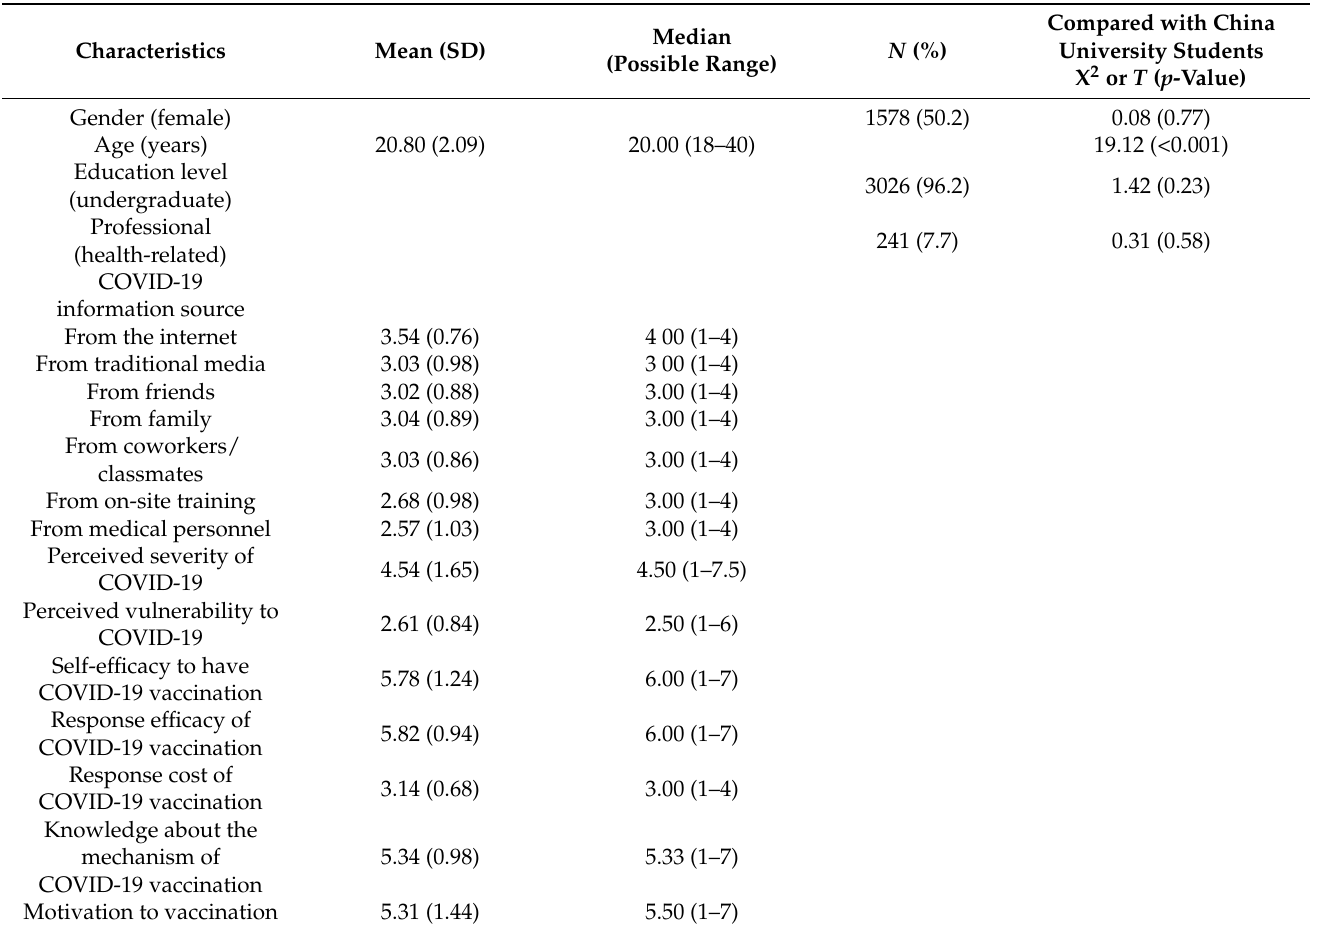
Table 2. Characteristics of the participants ( N =